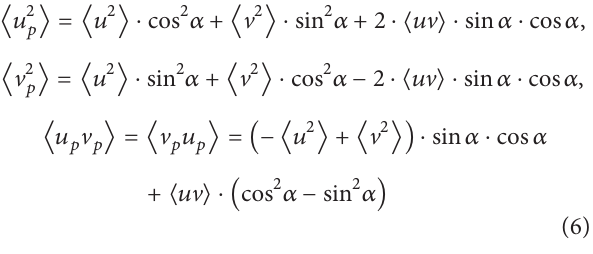
of the strain tensor, and not in the direction of the flow. By defining 𝛼 as the angle between the 𝑥 -axis and the